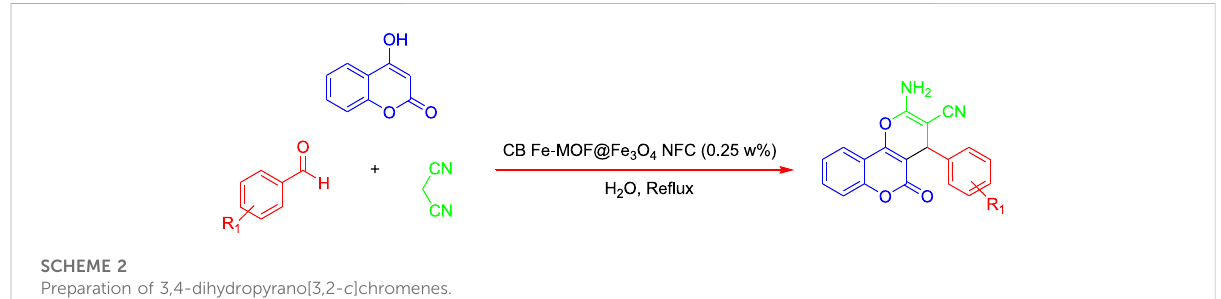
TABLE 1 Optimization of the reaction conditions for the synthesis of 3,4-dihydropyrano[c]chromene derivatives using CB Fe-hydroxyquinoline@Fe 3 O 4 NFC.